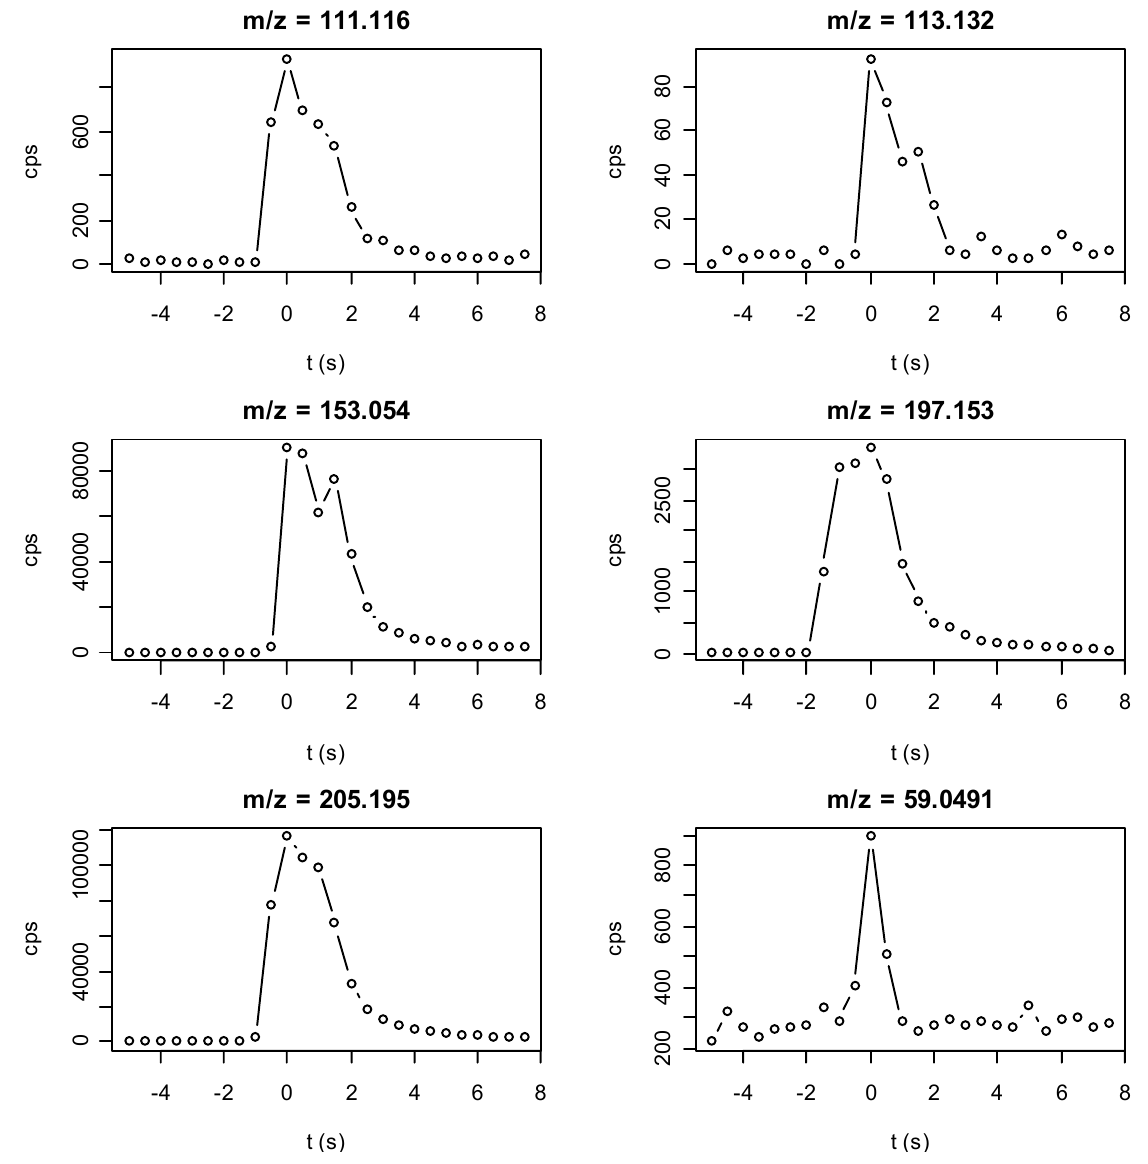
Figure 2. Examples of the time evolution of PTR-ToF-MS signal during gas bursts for the count rates of 5 ions used to monitor the investigated compounds. For each considered compound we show the time evolution of one of its fragments: 111.116 Th for 1-octen-3-ol, 113.132 Th for 1-octanol, 153.054 Th for methyl salycilate, 197.153 Th for pear ester and 205.195 Th for α -humulene. The signal at m/z = 59.049 Th corresponding to acetone (contaminant) is also